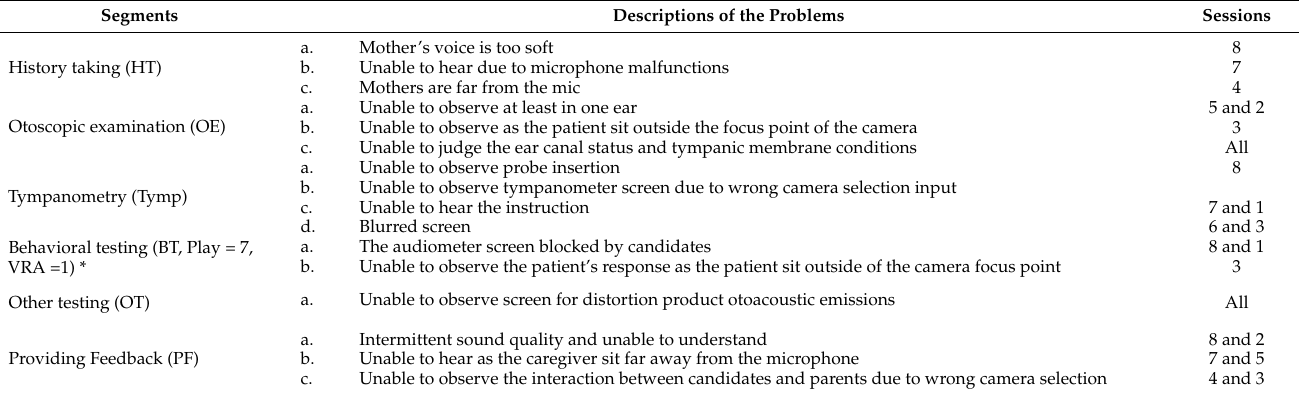
Table A2. Summary of the live